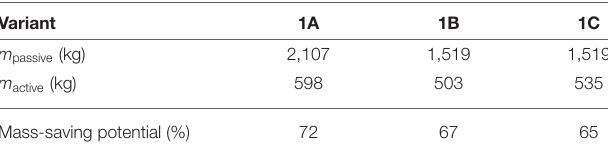
TABLE 1 | Example 1, truss design: total masses and mass-saving potentials (additional actuator mass not